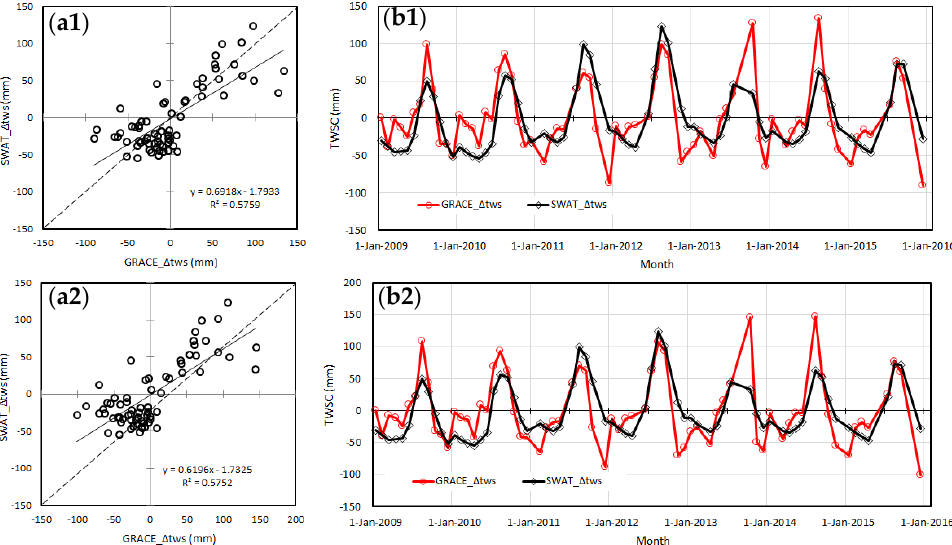
Figure 9. Comparison between monthly TWSC averaged over the study area in the Lake Chad Basin